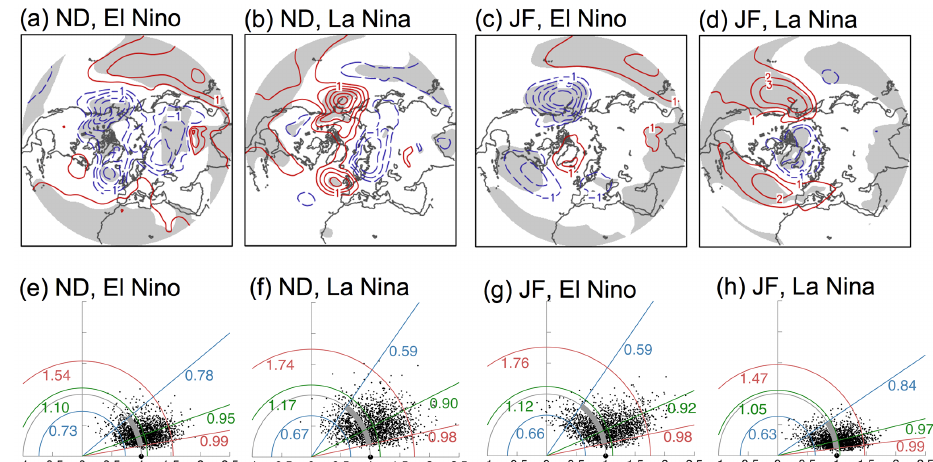
Figure 5. Uncertainty of ENSO (for El Niño or La Niña separately) teleconnection in the North Atlantic during 1870–2014 for the months shown. (a–d) SLP composites for El Niño or La Niña events. The contour interval is 0.5hPa for ND and 1hPa for JF, with red (blue) contours indicating positive (negative) anomalies. Gray shading indicates a 5% significance level for a two-tailed t test. (e–f) Corresponding Taylor diagrams for the North Atlantic with 2000 bootstrap SLP composites. Features in the Taylor diagrams are as described in Fig. 2. See Sects. 2.4 and 3.2 for more